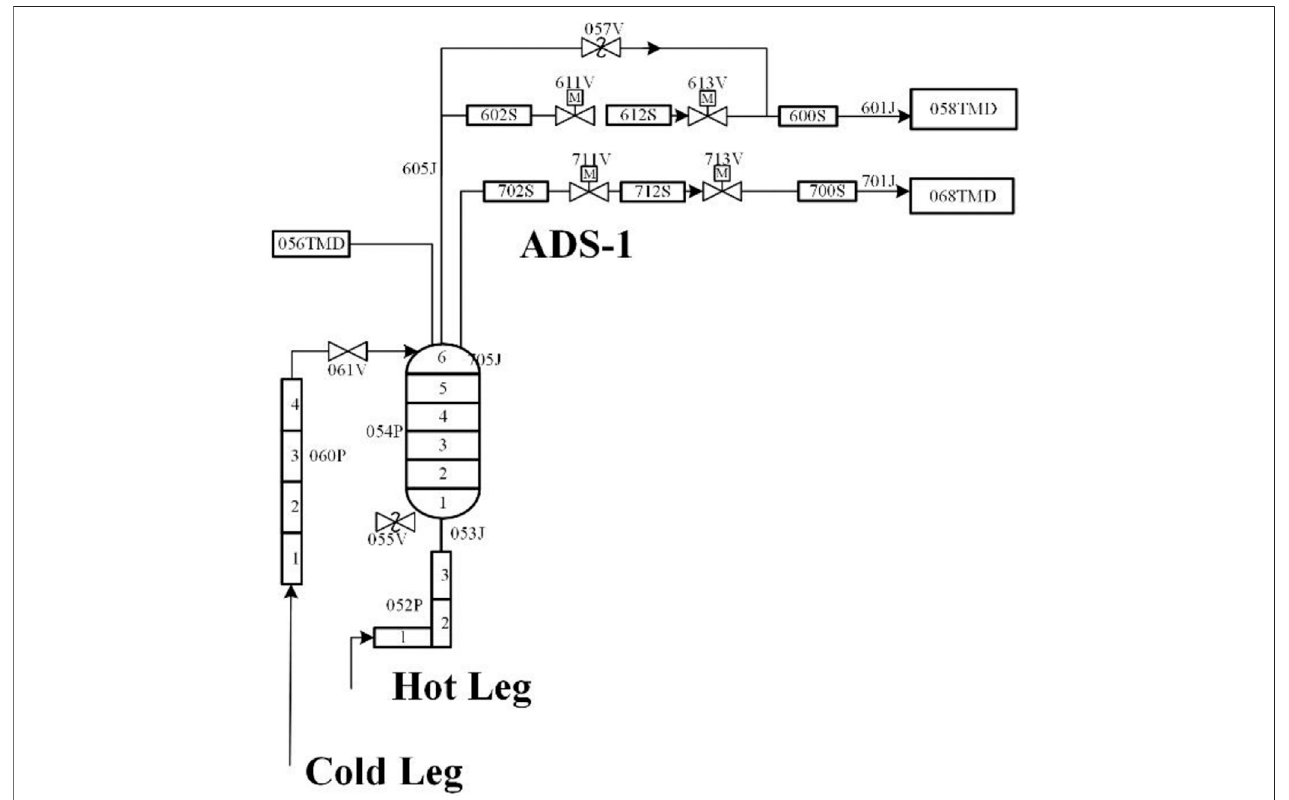
FIGURE 3 | ADS-1 system model.